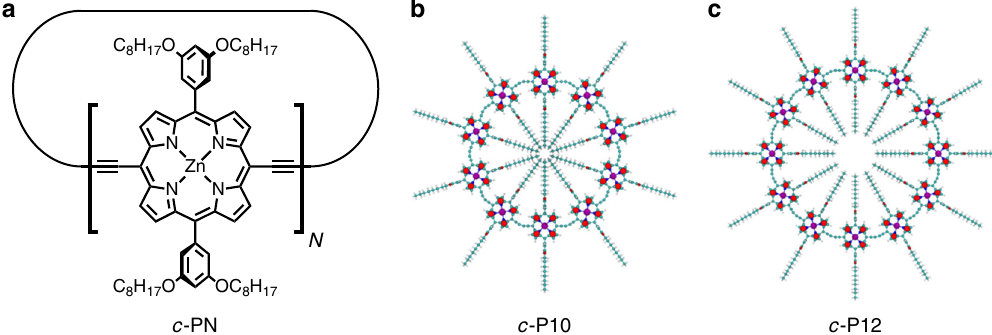
Fig. 1 Structure of c- PN (cyclic nanoring with N porphyrin groups) porphyrin nanorings. a Generic structural formula of cyclic c- PN polymer, b atomistic models of c- P10 and c c- P12 used in molecular dynamics